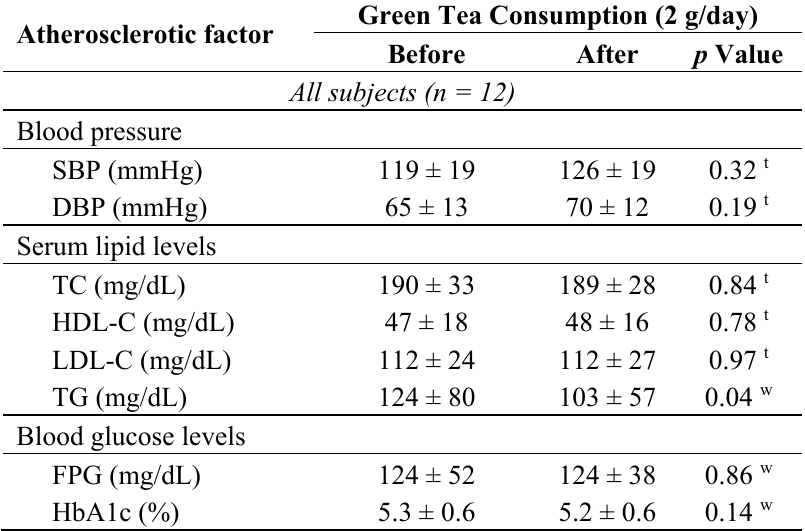
Table 3. Values of atherosclerotic factors before and after 3 months of green tea